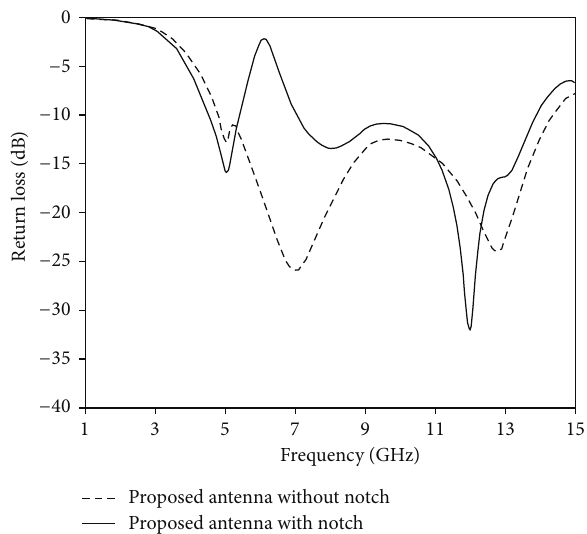
Figure 3: Simulated return loss of the proposed antenna with notch and without notch.